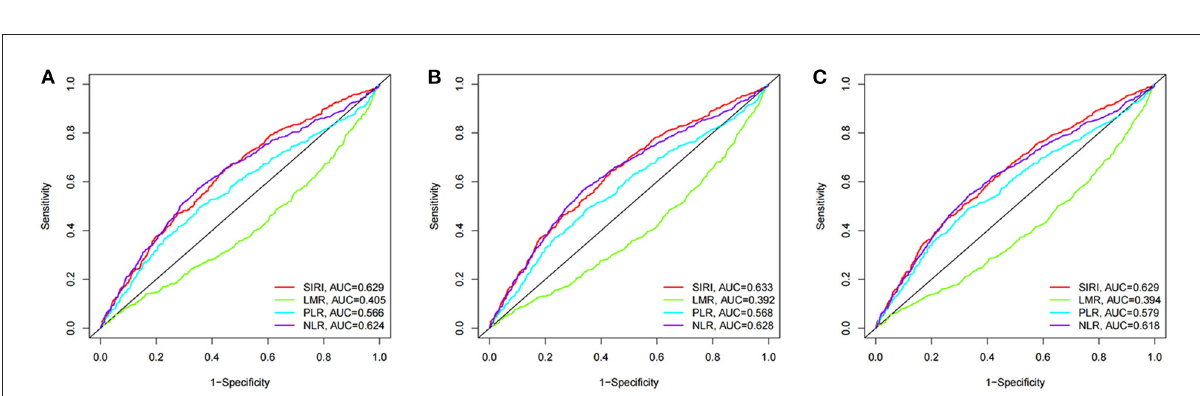
FIGURE7 The time-dependent ROC analysis for prognostic value in patients with acute ischemic stroke. (A) ROC curves corresponding to 90-day all-cause mortality. (B) ROC curves corresponding to 30-day all-cause mortality. (C) ROC curves corresponding to 1-year all-cause mortality.